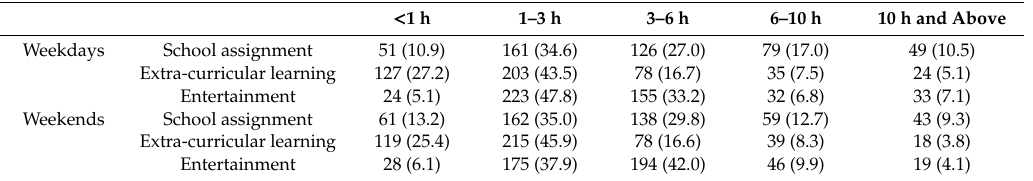
Table 1. Optional sedentary behavior of students majoring in design on workdays and weekends across each domain.